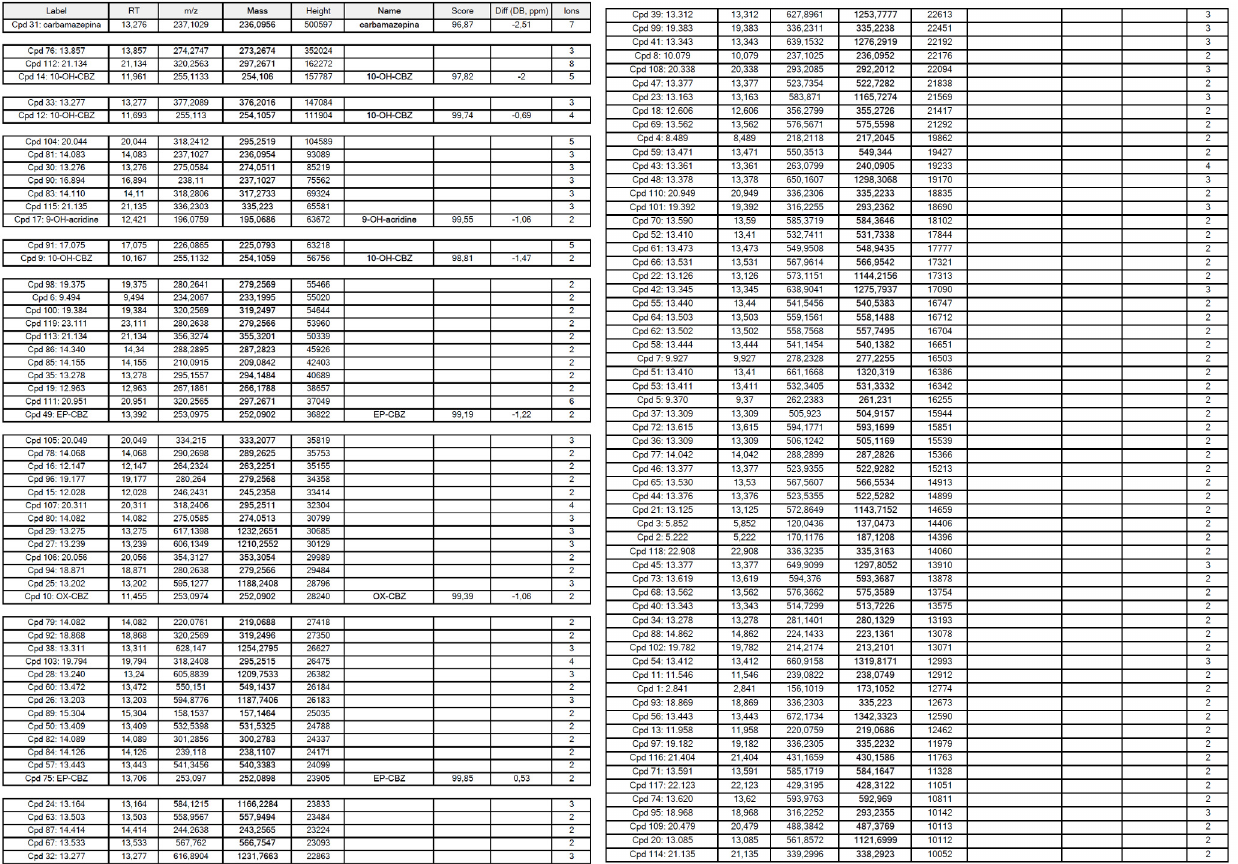
Figure A1. Major ions ( m / z ) and experimental masses calculated for each of the intermediate compounds detected in a sample of carbamazepine oxidized by photo-Fenton treatment under operating conditions that lead to the formation of coloured